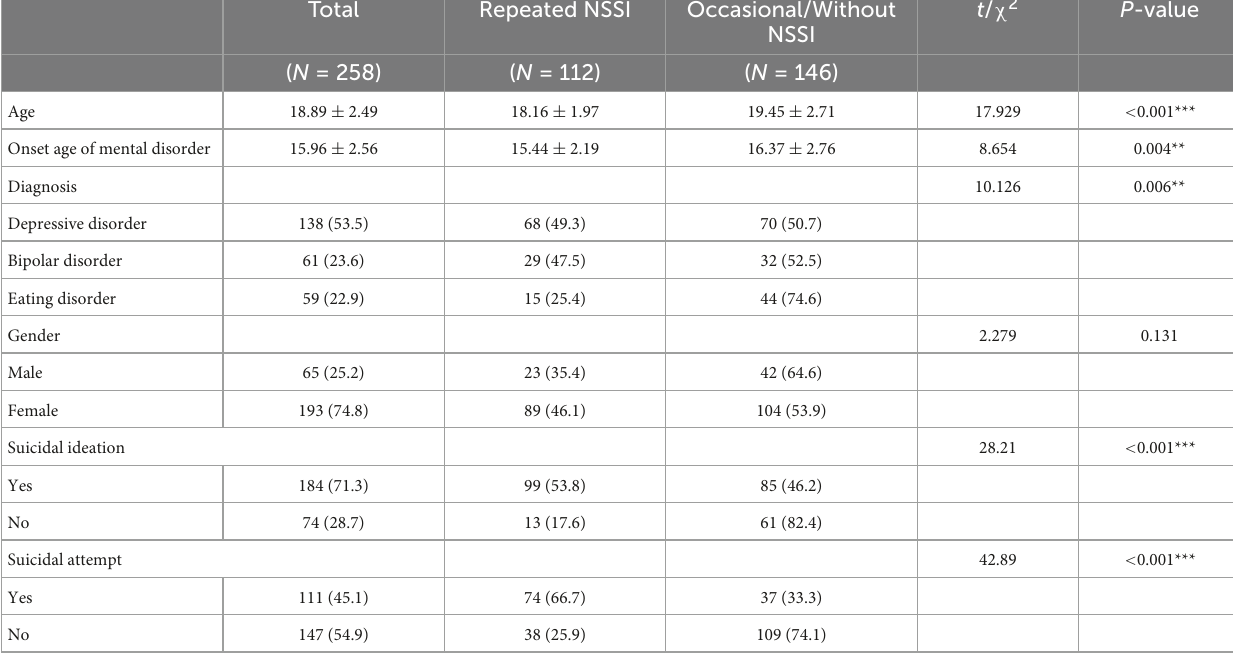
TABLE 1 Basic characteristics of participants [ N (%), mean ±